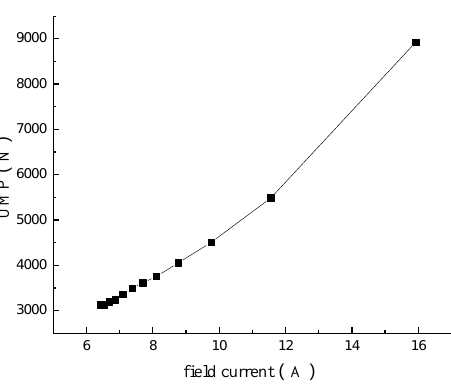
Figure 18. Synchronous generator grid-connected operation vector diagram.